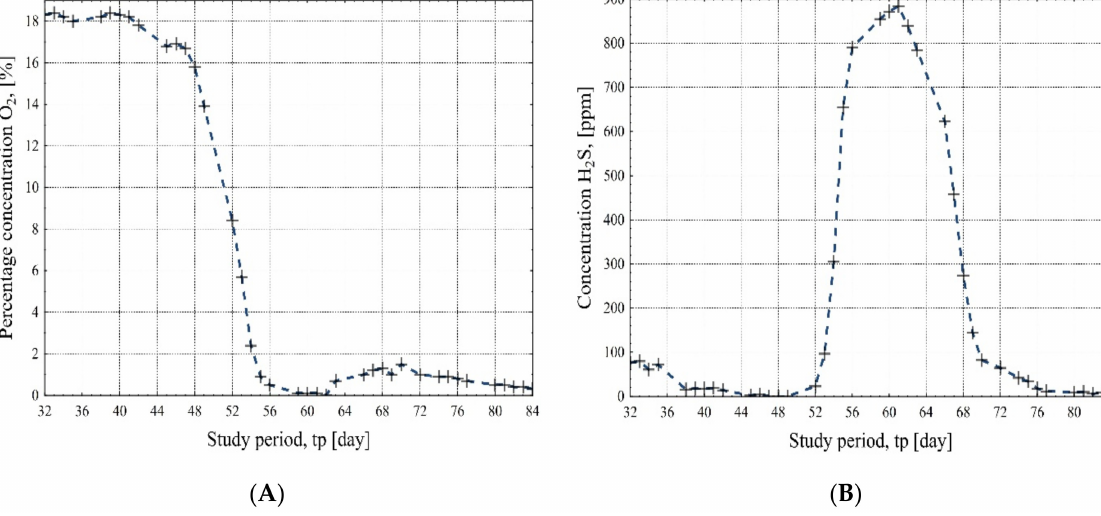
Figure 4. Change in the values of oxygen (O 2 ) percentage concentration (%) ( A ) and hydrogen sulfide (H 2 S) concentration (ppm) ( B ) depending on the duration of biogas installation start-up tp